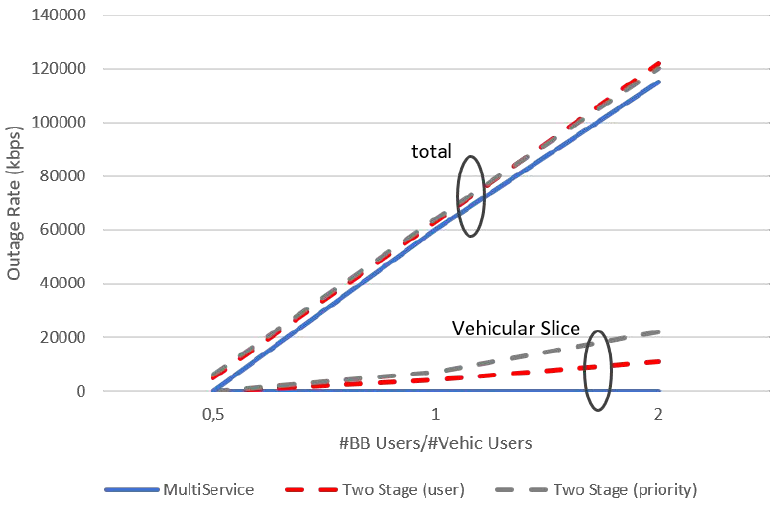
Figure 3. Outage rate of a two-slice